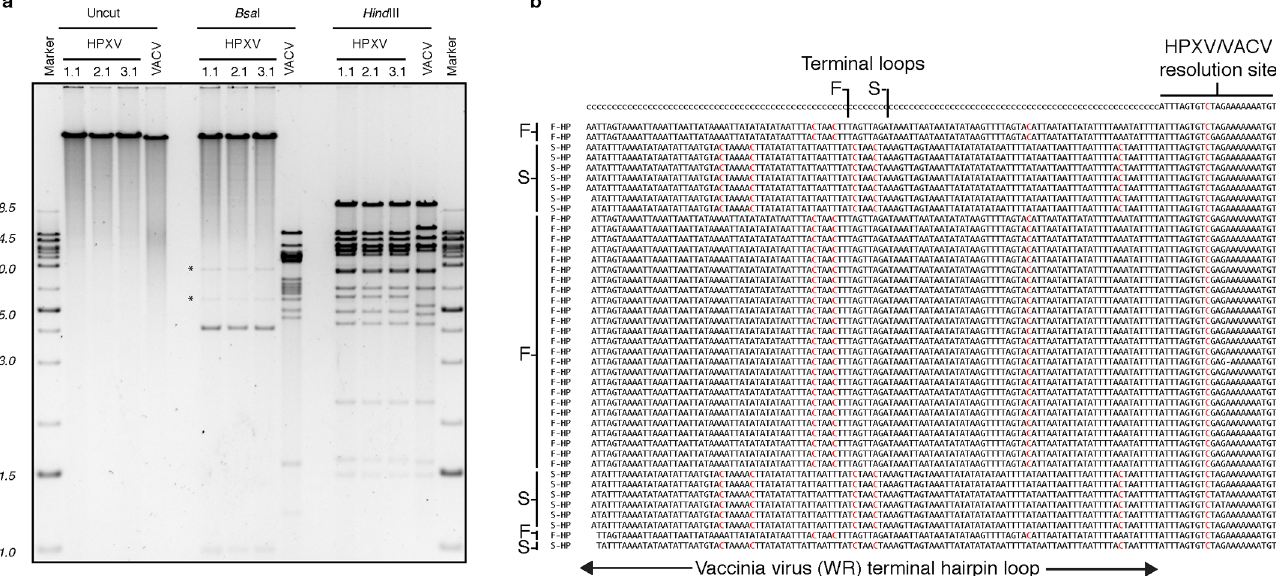
Fig 3. Sequencing and restriction endonuclease mapping of reactivated scHPXV YFP-gpt::095 clones. a . Pulsedfield gel electrophoretic analysis. Three independentHPXV clones plus a VACV (strain WR) control virus were purified and then left either untreated,or digestedwith Bsa I or Hin dIII. The larger size of HPXV relative to VACV is apparentin the uncut samples, and the absenceof nearly all of the Bsa I sites in the HPXV clones is also apparent.The selective manner in which only the Bsa I sites were modified by gene synthesis is illustratedby the retention of all the Hin dIII restriction sites in scHPXV YFP-gpt::095. The Hin dIII digest also demonstrates the similaritiesbetweenHPXV and VACV as illustratedby the related digestionpatterns. The faint DNA bands marked with asterisks ( * ) are from monkey cell mitochondria, which co-purify with poxvirus particles. b . Sequencereads associated with the hairpintelomeres. The viruses were sequencedusing Illumina technology and the genomesassembledusing CLC genomicssoftware. A subset of the longest sequencing reads, extendingbeyondthe known end of the HPXV sequence,are shown aligned against a poly (cid:1) dCtemplate. (This method captures sequencesextendingbeyondthe point where the reference sequenceends.) These reads span the entire length of the unfolded hairpinsas was providedusing synthetic oligonucleotides. Becauseof the invertedterminal duplications, all of the reads “pile up” together. Both F- and S-forms of the VACV hairpinare detected and the ratio of F- to S-reads in this regionwas 1.03 ± 0.01(SEM) in eight different virus-sequencing